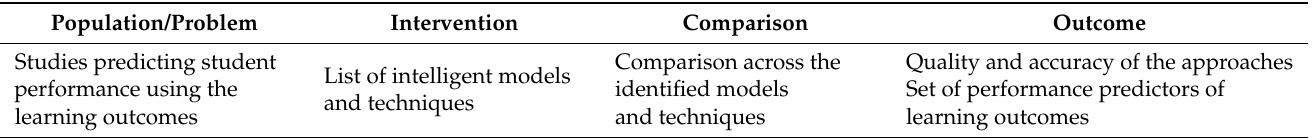
Table 2. PICO protocol adopted in our